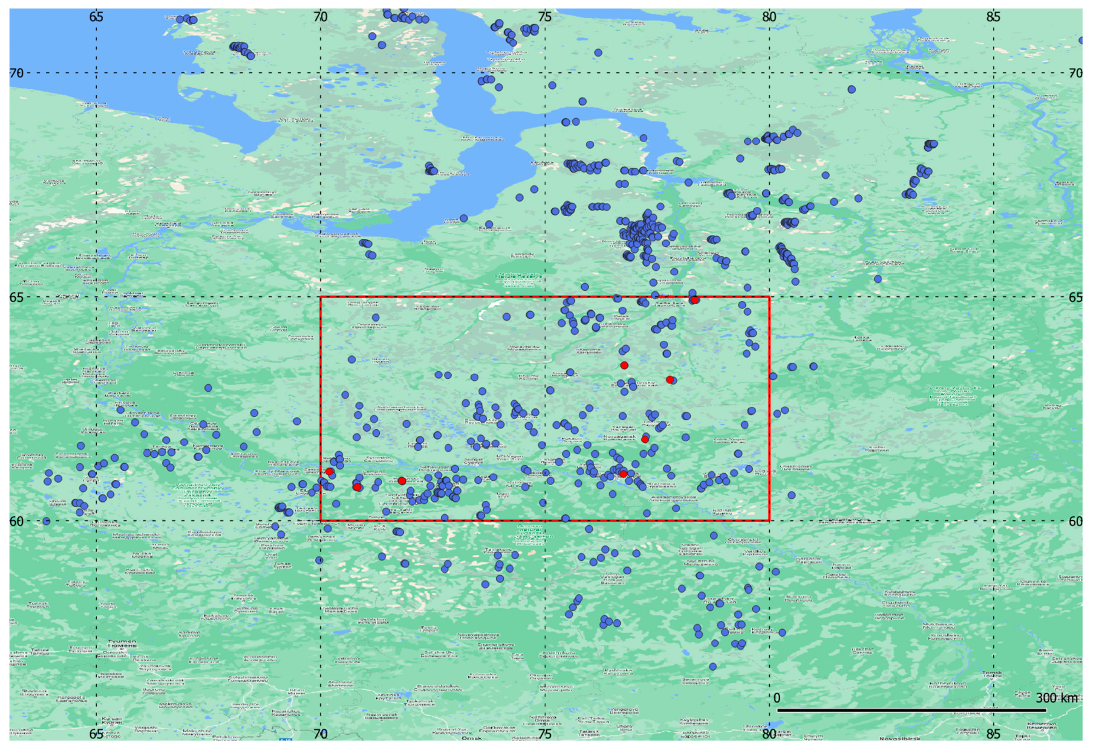
Figure 11. ROI with gas flares from oil fields in Khanty-Mansiysk Autonomous Okrug (NW corner coordinates: 65N 70E; SE corner: 60S 80E). Upstream gas flares detected with VNF in 2021 are shown with blue circles. Gas flares used in this study are shown with red circles. Background is from Google Maps.